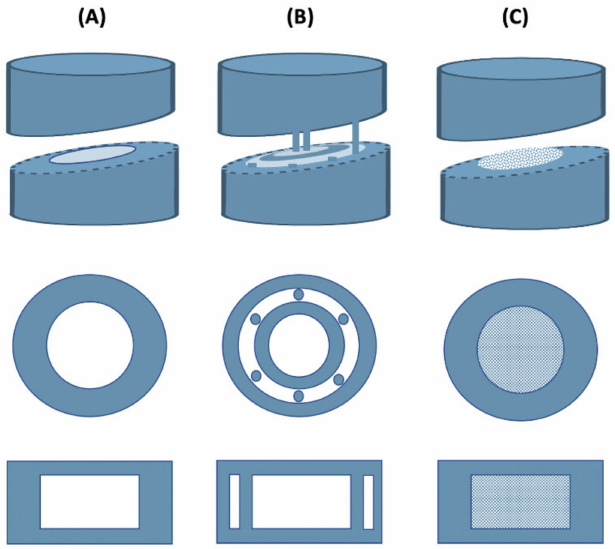
Figure 3. 3D-printed levetiracetam pediatric formulations. ( A ) Hollow structure, ( B ) Hollow structure with internal support, ( C ) Lattice